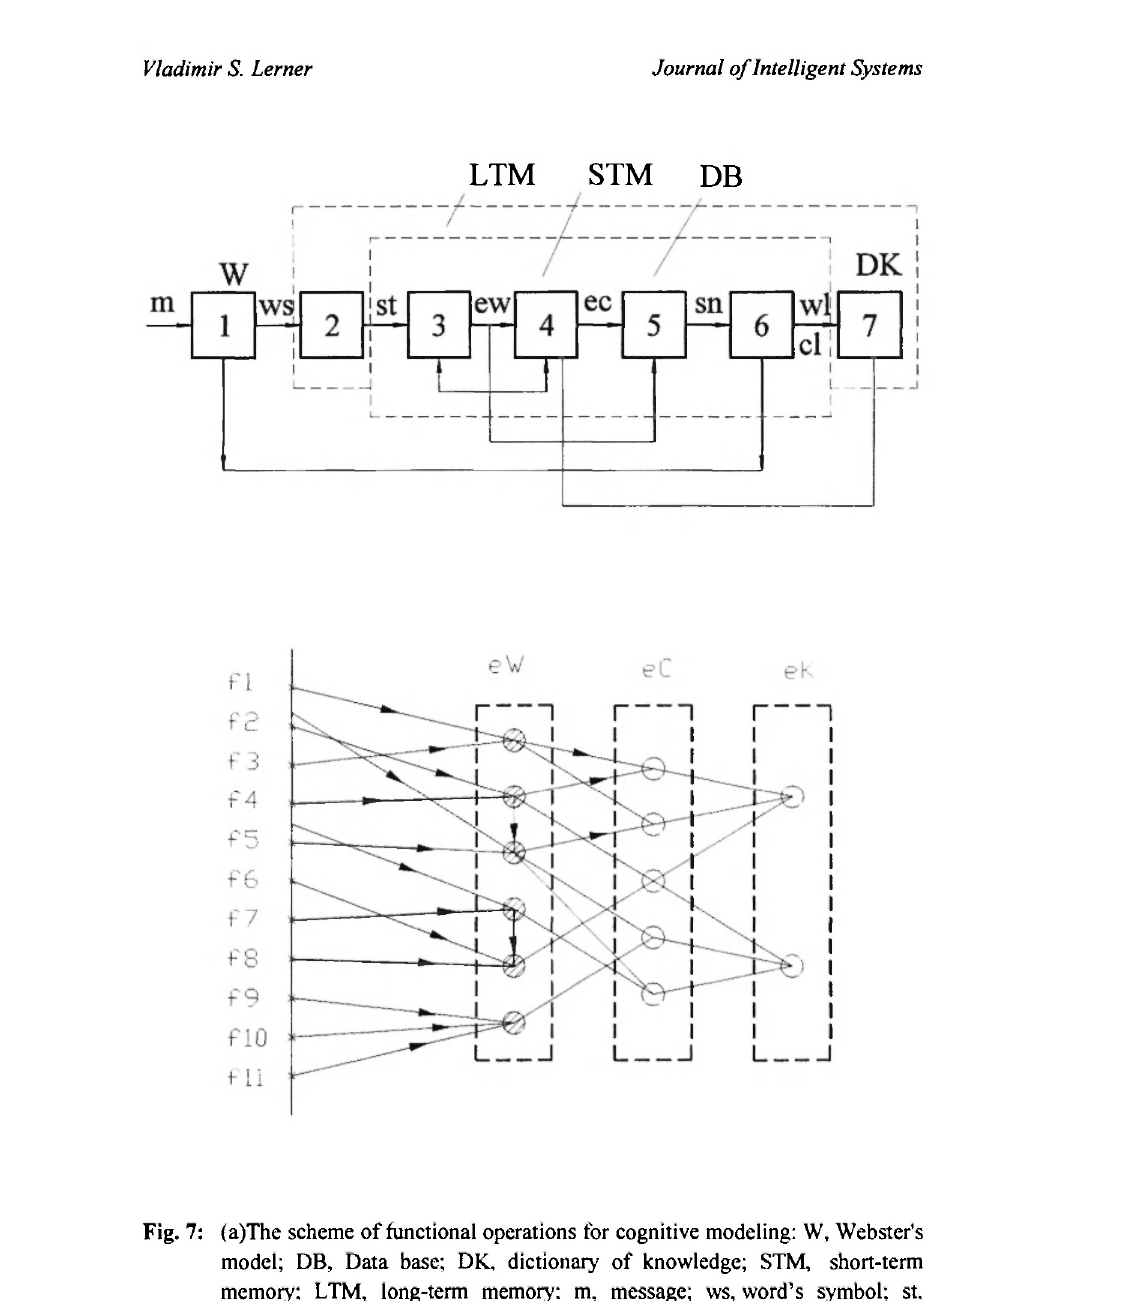
Fig. 7: (a)The scheme of functional operations for cognitive modeling: W, Webster's model; DB, Data base; DK, dictionary of knowledge; STM, short-term memory: LTM, long-term memory; m, message; ws, word's symbol; st, symbol's frequency; ew, encoded word; ec, encoded concept; sn, spot's node; wl, word's label: cl, concept's label, (b) Encoding words (eW), concepts (eC), and knowledge (eK), using the IF